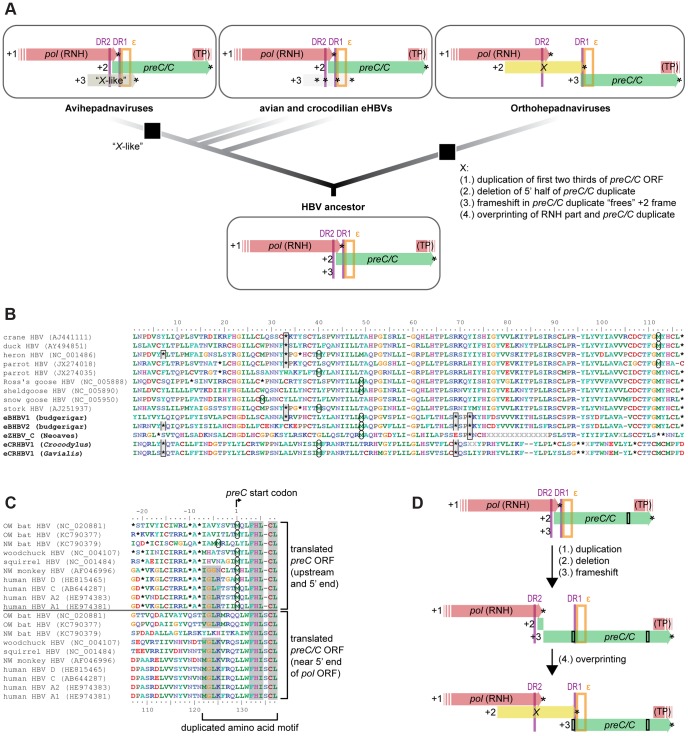
An evolutionary scenario for the emergence of the oncogenic X gene.(A) The genome of the HBV ancestor contained neither an X nor X-like ORF, given that avian and crocodilian eHBVs lack an X-like ORF, despite the fact that it is thought to be expressed in some closely related avihepadnaviruses [20]. X (+2 frame) and X-like (+3 frame) are encoded in different reading frames relative to the part of pol they overlap with (+1 frame), which strongly suggests that these ORFs are non-homologous and the X-like protein emerged in the ancestor of avihepadnaviruses. Independently, the X protein arose in orthohepadnaviruses via overprinting (4.) after a segmental duplication (1.), a partial deletion (2.), and a frameshifting mutation (3.) in one region of the HBV genome. Only the part of the HBV genome between the ribonuclease H (RNH) and the terminal protein (TP) domains of the pol ORF is shown, including structural elements such as direct repeats (DR; purple vertical lines) and the RNA encapsidation signal (ε; orange box). (B) Translated sequence alignment of the X-like ORF sensu Chang et al. [20] indicates presence of multiple internal stop codons in avian and crocodilian eHBVs, resulting in potential translation products <30 aa. Stop codon positions (asterisks) are highlighted with grey boxes if they are conserved between eHBVs, start codon positions for the longest possible ORF are highlighted by circles. Even when assuming that nonconventional start codons are used as suggested for DHBV [20], potential eHBV X-like proteins would comprise just a portion of the DHBV X-like protein. (C) Sequence similarity between translated preC/C 5′ end region (incl. in-frame aa sites upstream of the start codon) and translated central region of the preC/C ORF might be a potential remnant of an ancient segmental duplication of the first two thirds of the preC/C ORF. Amino acid residues with dark grey background are conserved between the start and the middle part of the preC/C ORF and thus constitute a potentially duplicated amino acid motif. (D) Schematic illustration of the proposed evolutionary steps of X ORF emergence [(1.) to (4.)] described in (A) that potentially led to the extant genome organization of orthohepadnaviruses. Black rectangles illustrate the location of the duplicated amino acid motif shown in (C).